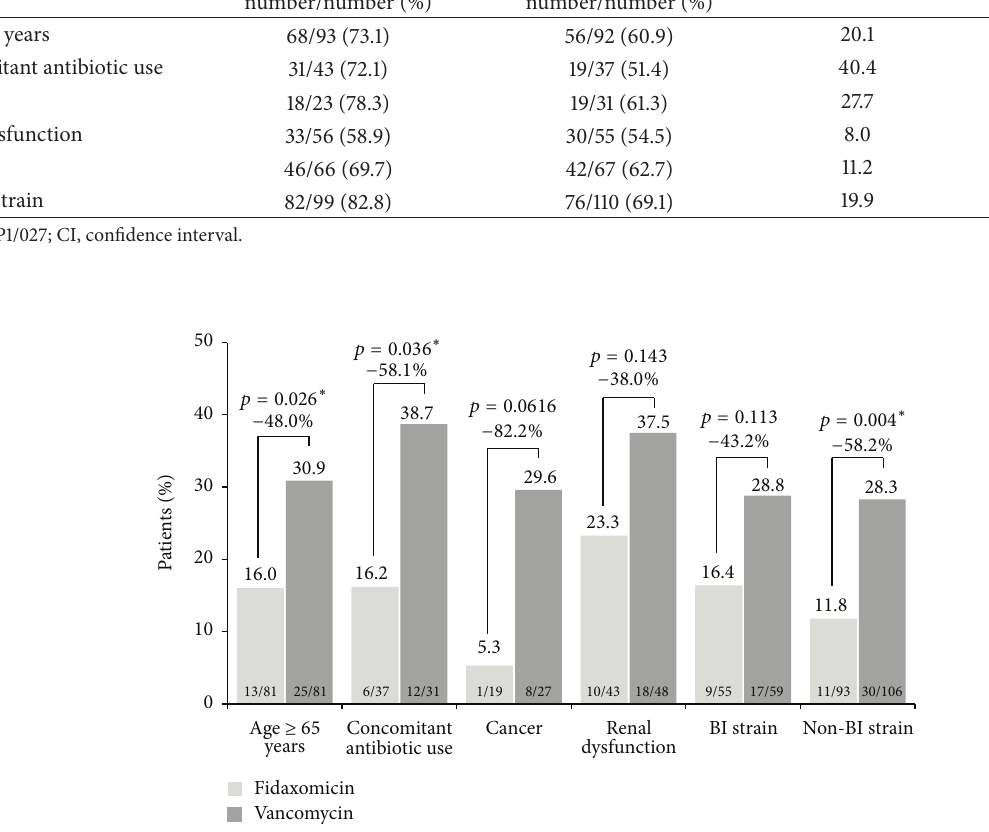
Figure 3: Rates of recurrence in subgroups. ∗ 𝑝 < 0.05